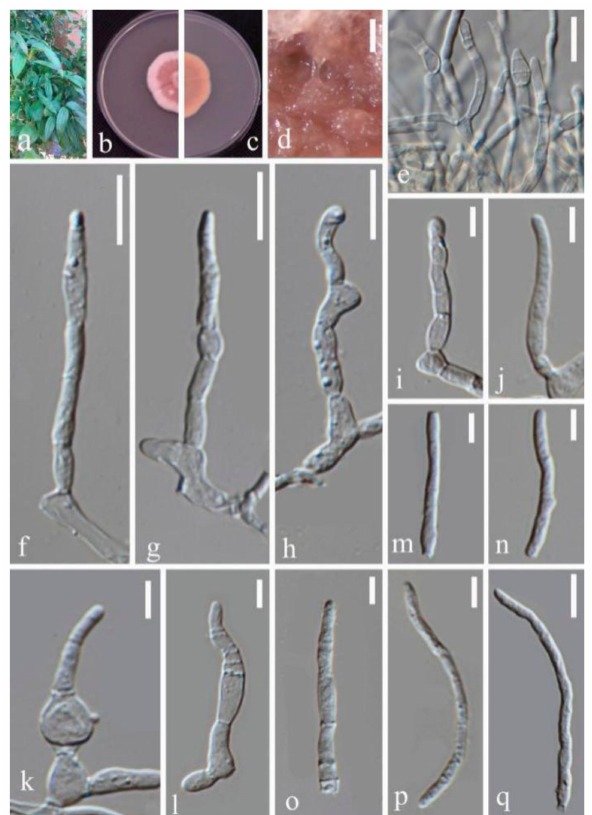
Figure 7. Septoria protearum (GUCC 2127.3) ( a. Leaf spot symptoms on the host. ( b , c ) Colony on PDA. ( b ) From above; c. from below). ( d ) Mycelium. ( e ) Conidiophores. ( f – l ) Conidiogenous cells and conidia. ( m – q ) Conidia. Scale bars: ( d ) = 125 µ m. ( e – h ) = 10 µ m. ( i ) = 5 µ m. ( j – q ) = 10 µ